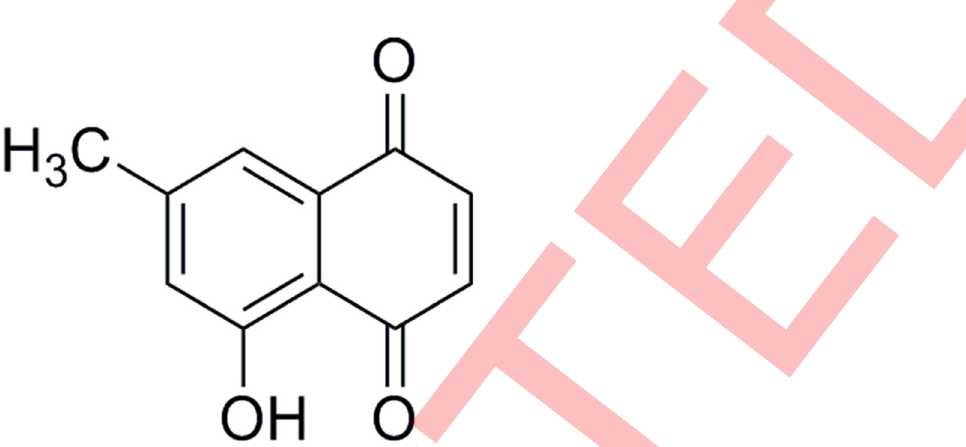
Fig 1. Structure of ramentaceone (5-hydroxy-7-methyl-1,4-naphthoquinone).